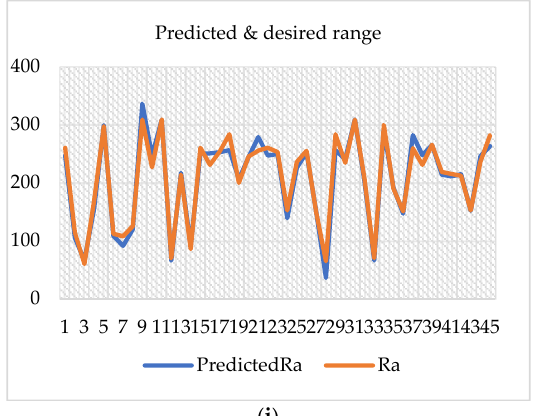
Figure 15. Redefined parametric predictions performance measurement. ( a ) City electric charge consumption; ( b ) Highway electric charge consumption; ( c ) Combined electric charge consumption; ( d ) Electric motor power; ( e ) City gasoline litre consumption equivalent; ( f ) Highway gasoline litre consumption equivalent; ( g ) Combined gasoline litre consumption equivalent; ( h ) Recharge Time; ( i ) Range.